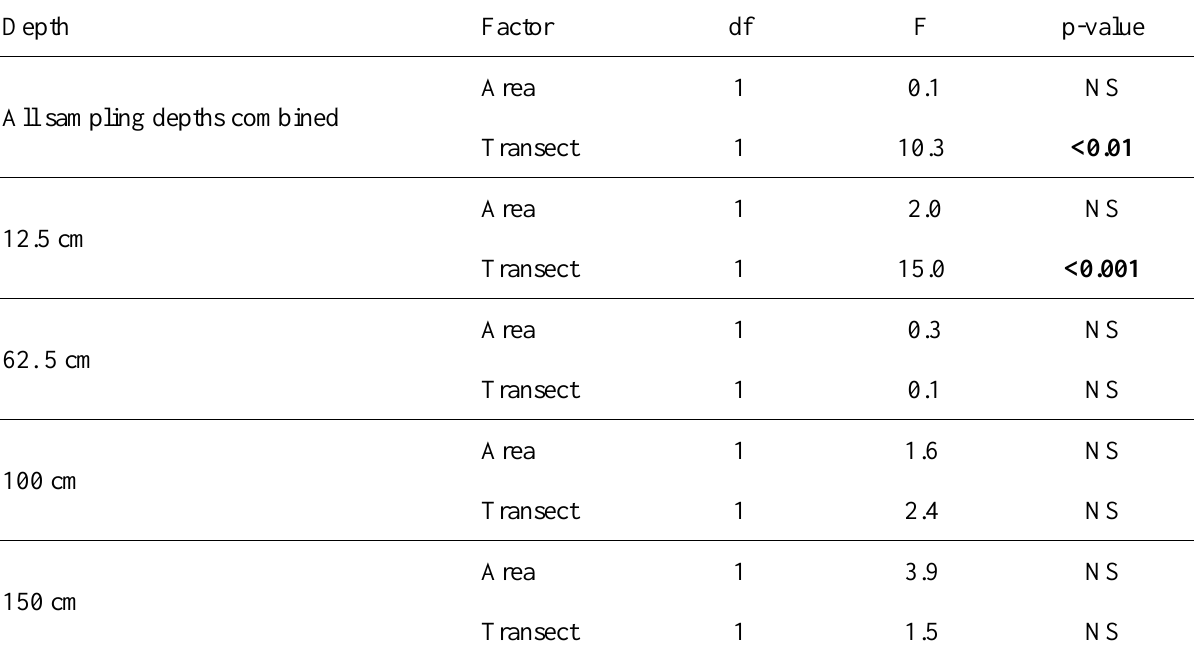
Table 1. The effects of area (Forest vs Open) and transects (Transect 1 vs. Transect 2) on ash content, for all sampling depths combined, and for selected sampling depths (12.5 cm, 62.5 cm, 100 cm and 150 cm), analysed using two-way ANOVA. Ash content values (%) were arcsine-transformed prior to ANOVA, conducted at α = 0.05. Significant p-values are highlighted in bold.